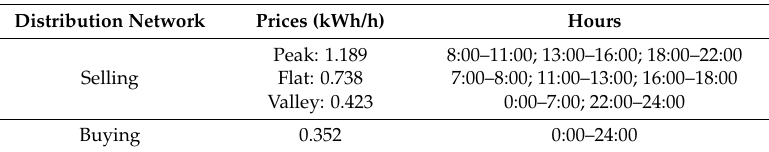
Table 1. Time-of-use tariff.